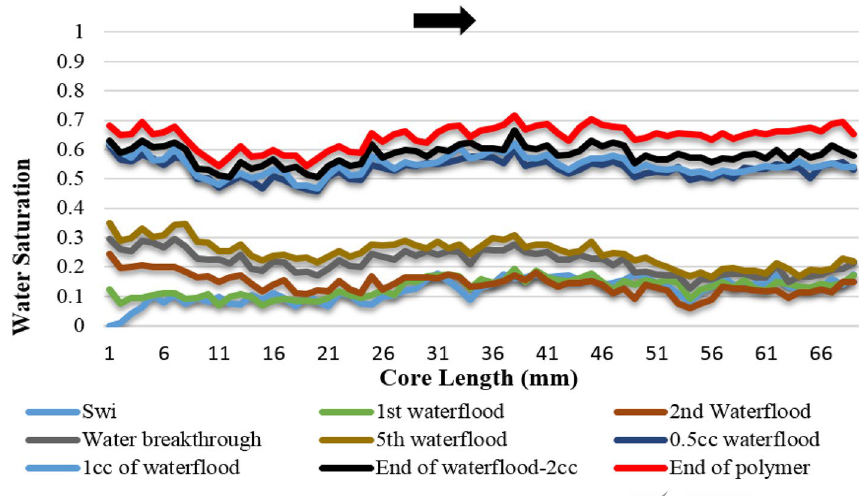
Fig. 5 ISSM profile with respect to fluid injected along the core length during